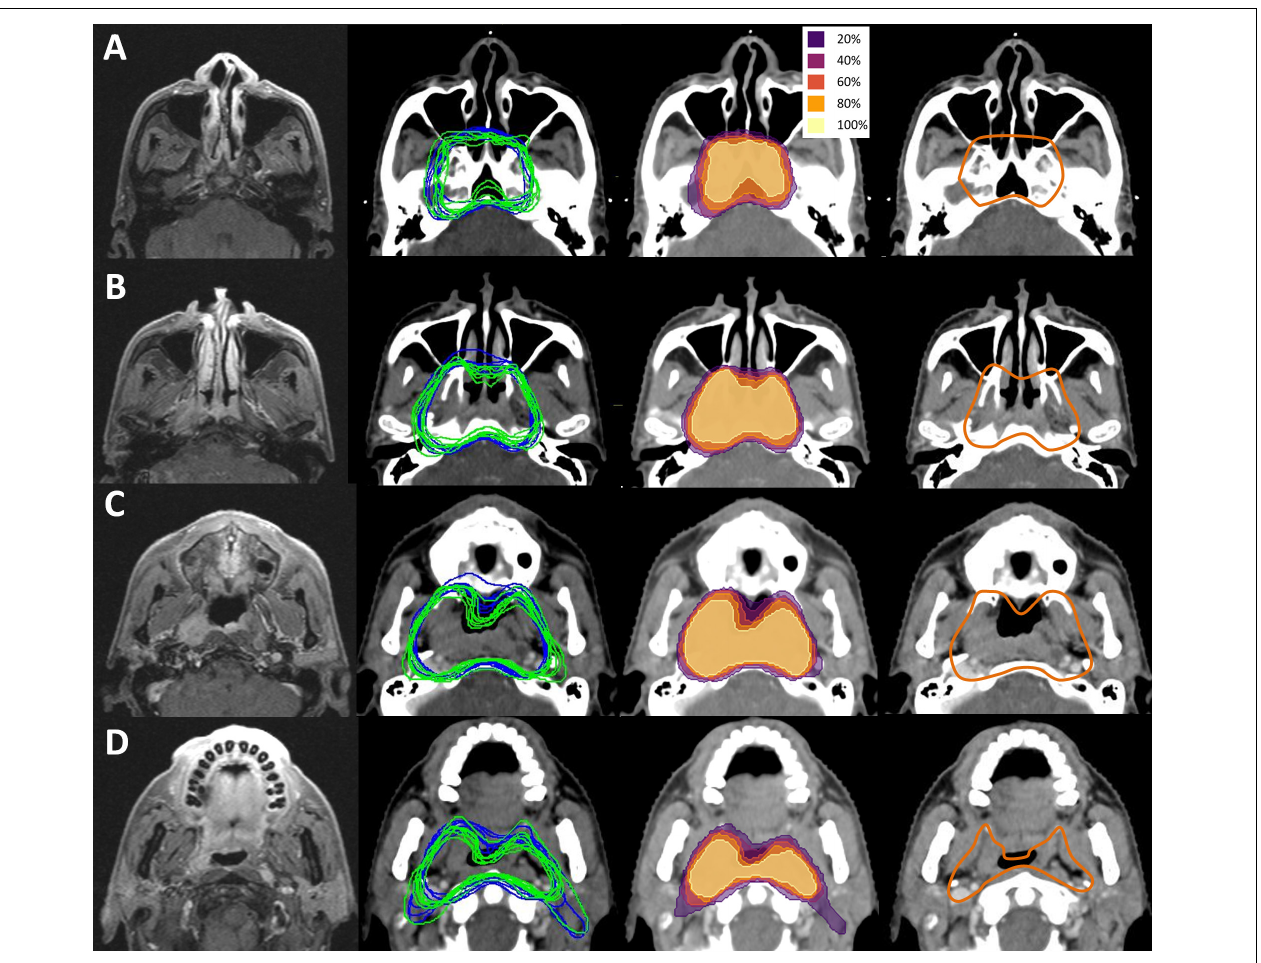
FIGURE 3 | CTV coverage displayed as probability map and comparison to international CTV consensus of NPC. Left panel, T1 contrast enhanced MR images, middle left panel, original contouring of CTV60 of one-CTV design (blue lines) and CTV54 of two-CTV design (green lines), middle right panel, heat map showing involved probability of anatomical area, right panel, CTV recommended by the international consensus. Note the high consistence between contouring of Chinese physicians and recommendation of international consensus. However, some differences were also appreciable. (A) The difference in covering maxillary sinus at contra-lateral side. Note most Chinese physicians covered less than the consensus. (B) Difference in covering parapharyngeal space and lateral pterygoid plate at middle plane of maxillary sinus. Most Chinese physicians covered less than consensus at contra-lateral side. (C) Difference in covering parapharyngeal space and lateral pterygoid plate at hard plate level. Pterygoid process at contra-lateral side was spared, and medial edge of lateral pterygoid plate was used as left border by most physicians. (D) Difference in covering parapharyngeal space and posterior space of styloid process. At this level, the front part of the parapharyngeal space was spared for both sides by most Chinese